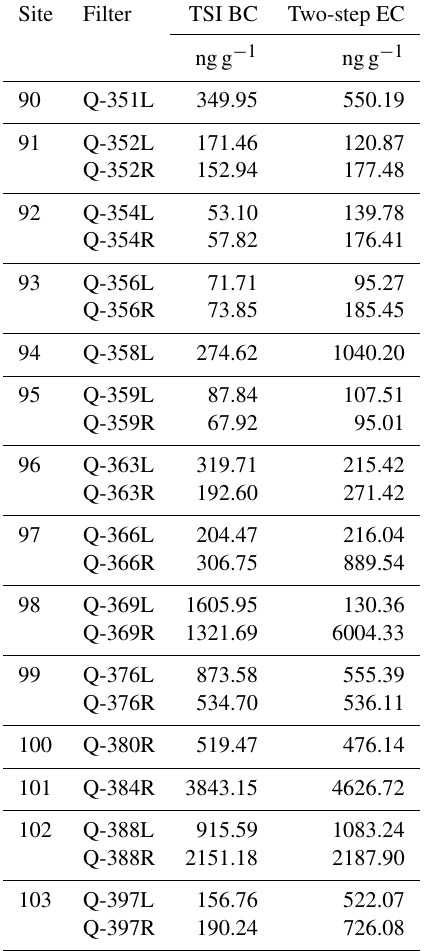
Table 2. Statistics of BC and EC concentrations measured using the TSI and two-step thermal–optical methods for snow samples during the experiments over northern